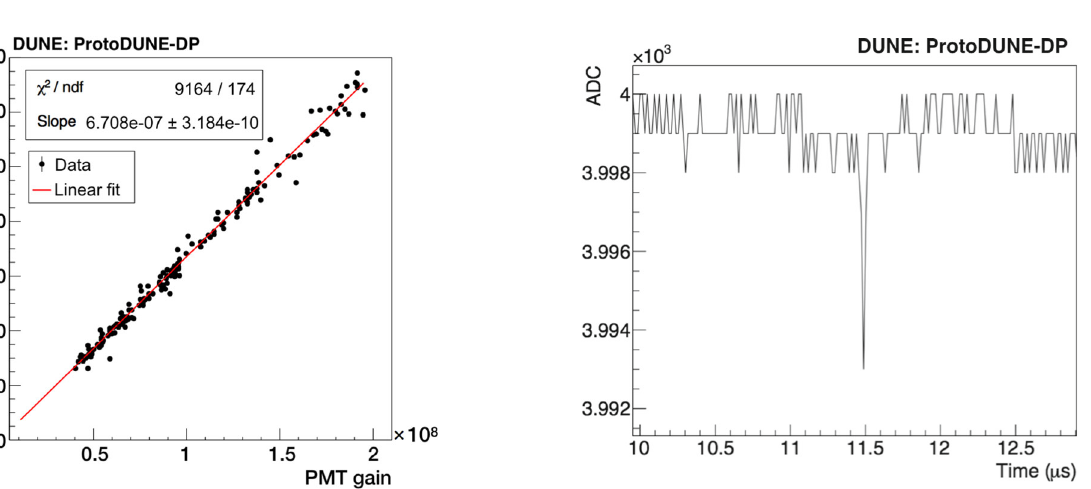
Fig. 7 Gain ( G ) stability with time for the 36 PMTs (one color per PMT) evaluated at 1500V represented with respect to the average gain < G >